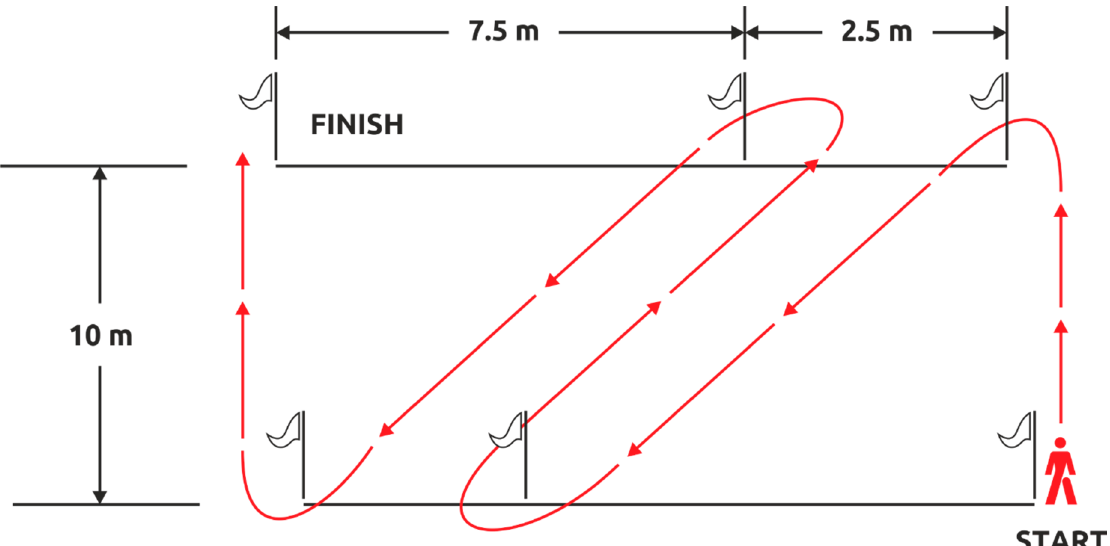
Figure 1. The Curved Sprint Test.